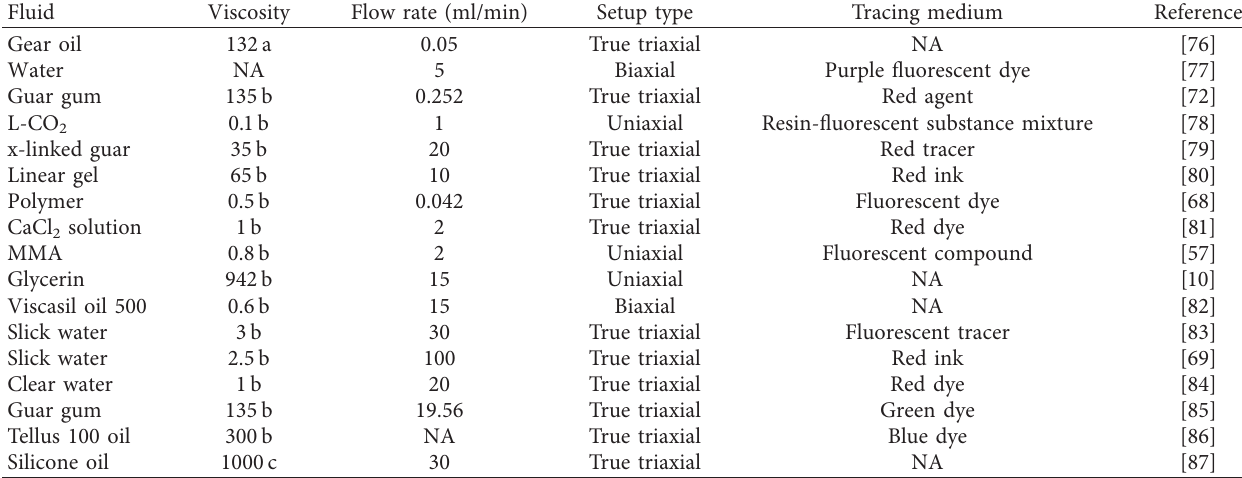
Table 1: Summary of the commonly adopted fluids for laboratory-scale hydraulic fracturing experiments.